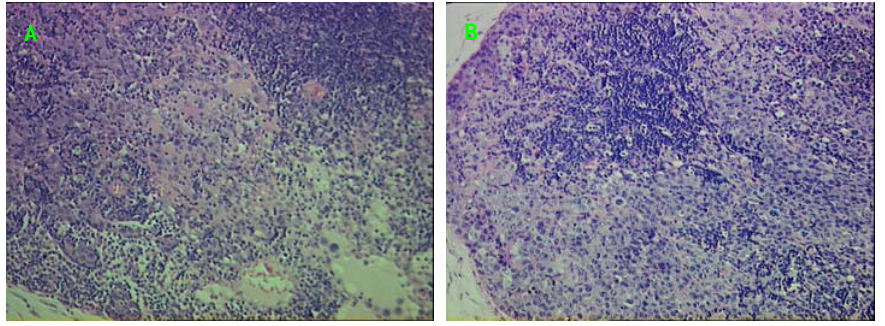
Figure 4. Histology of Buccal cancer cervical lymph node metastasis (HE staining, 200  ). ( A ) U14/QD800 buccal cancer cervical lymph node metastasis; ( B ) U14 buccal cancer cervical lymph node